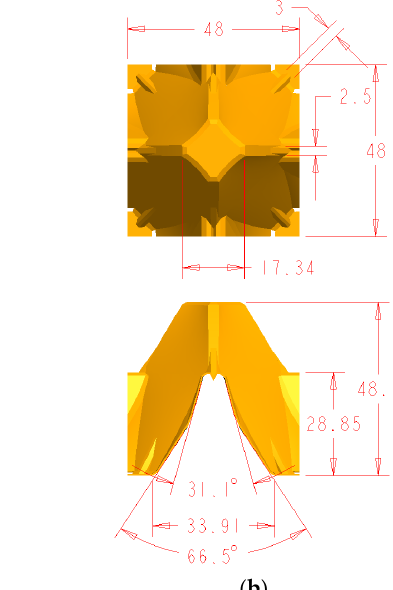
Figure 3. The drawing of the basic model ( a ) and of the modified model ( b ).